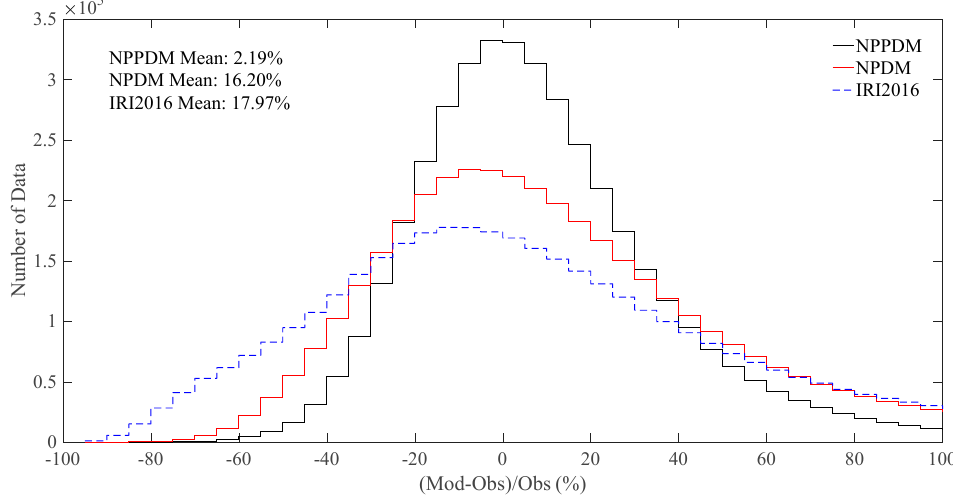
Figure 2. Histogram of relative deviation.